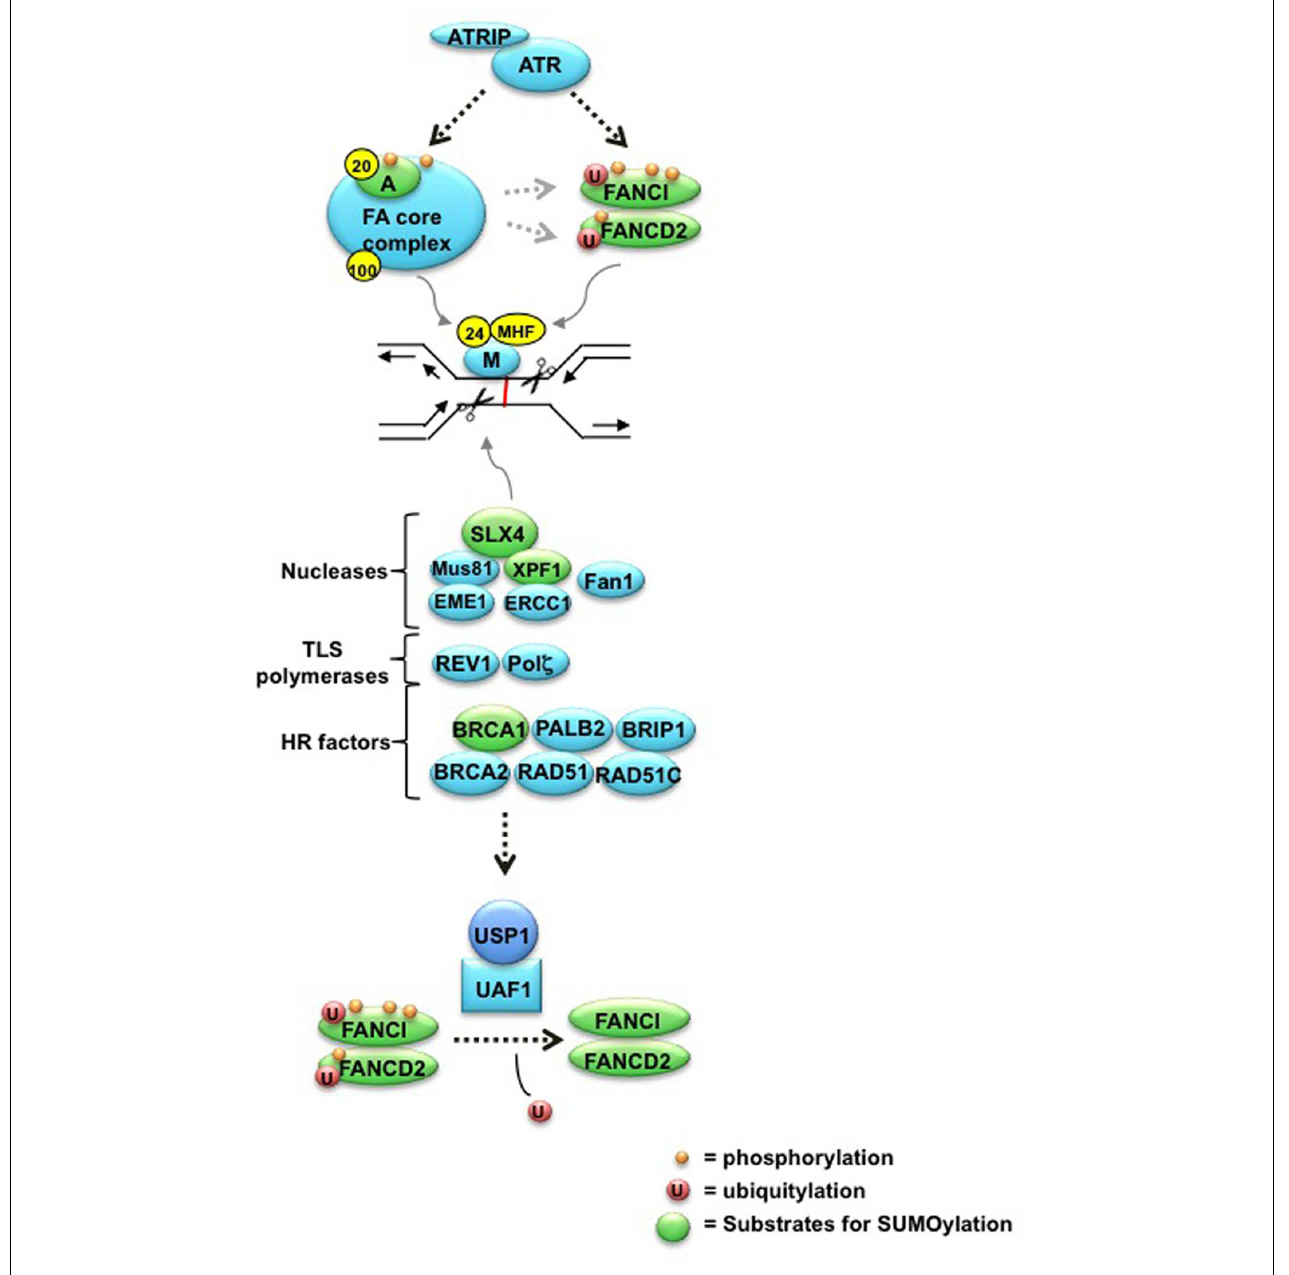
FIGURE 1 | The ICL repair pathway. The FANCM-FAAP24 complex first recognizes stalled replication structures, and recruits the FA core complex to the ICL. ATR-Chk1 phosphorylates and activates multiple components, including FANCA, E, I, and D2, which is required for monoubiquitylation of the ID complex by the FA core complex. Upon monoubiquitylation, the activated ID complex localizes to chromatin and coordinates the activities of downstream nucleases that create incisions around the crosslink. The resulting structure is then repaired by multiple processes, involving lesion bypass by TLS polymerases, HR, and NER. Finally, the USP1-UAF1 DUB complex removes monoubiquitin from the ID complex to complete repair. See accompanying text for more details. Yellow spheres indicate Fanconi Anemia-associated proteins (FAAPs) FAAP20, FAAP24, and FAAP100. Targets for SUMOylation highlighted in this review are denoted in